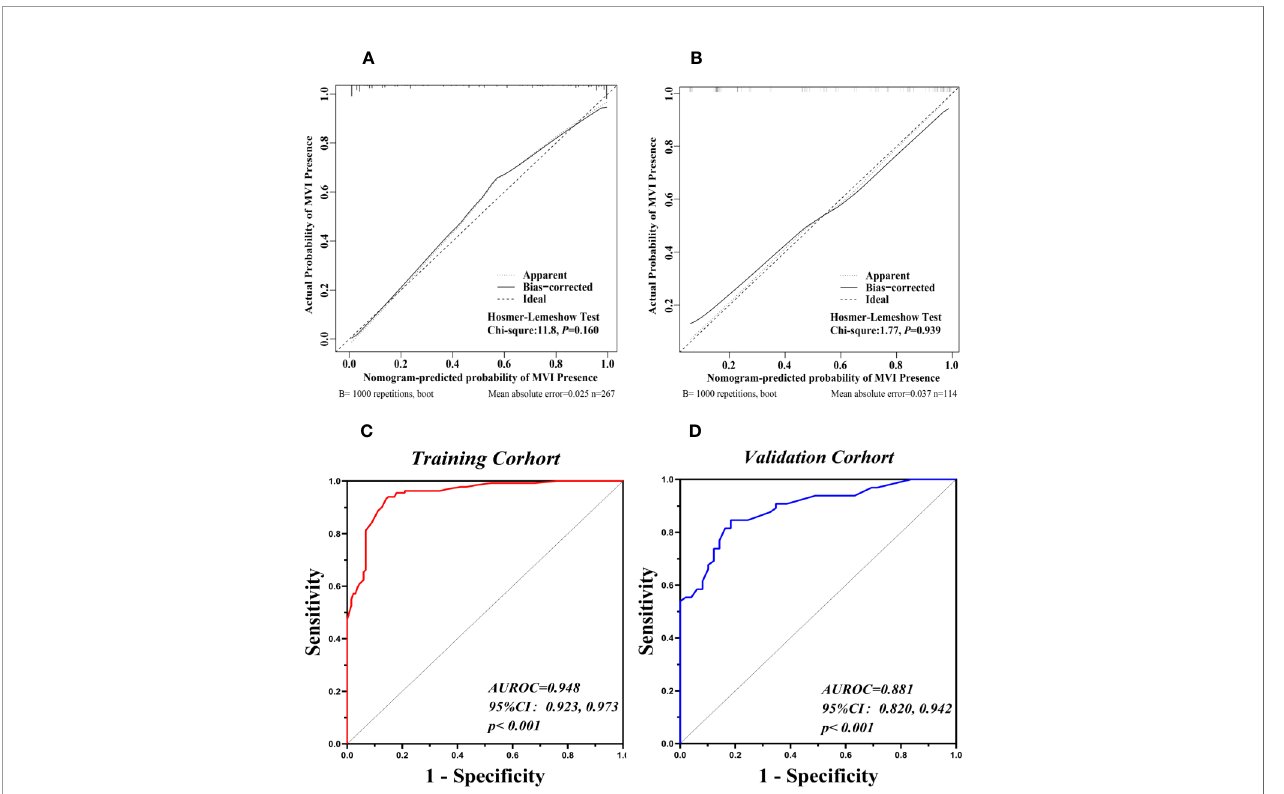
FIGURE 6 | Validation of the Nomograms for prediction of MVI. The calibration curves for predicting presence of MVI in the training cohort (A) and the validation cohort (B) . Nomogram-predicted MVI presence was plotted on the X-axis, and the actual MVI presence was plotted on the Y-axis. A plot along the 45° line would indicate a perfect calibration model in which the predicted presence are identical to the actual presence. The apparent line represented the fi tting line between the predicted situation of the model and the actual situation. The ROC curves of the nomogram in the training cohort ( C, AUROC: 0.948) and the validation cohort ( D, AUROC: